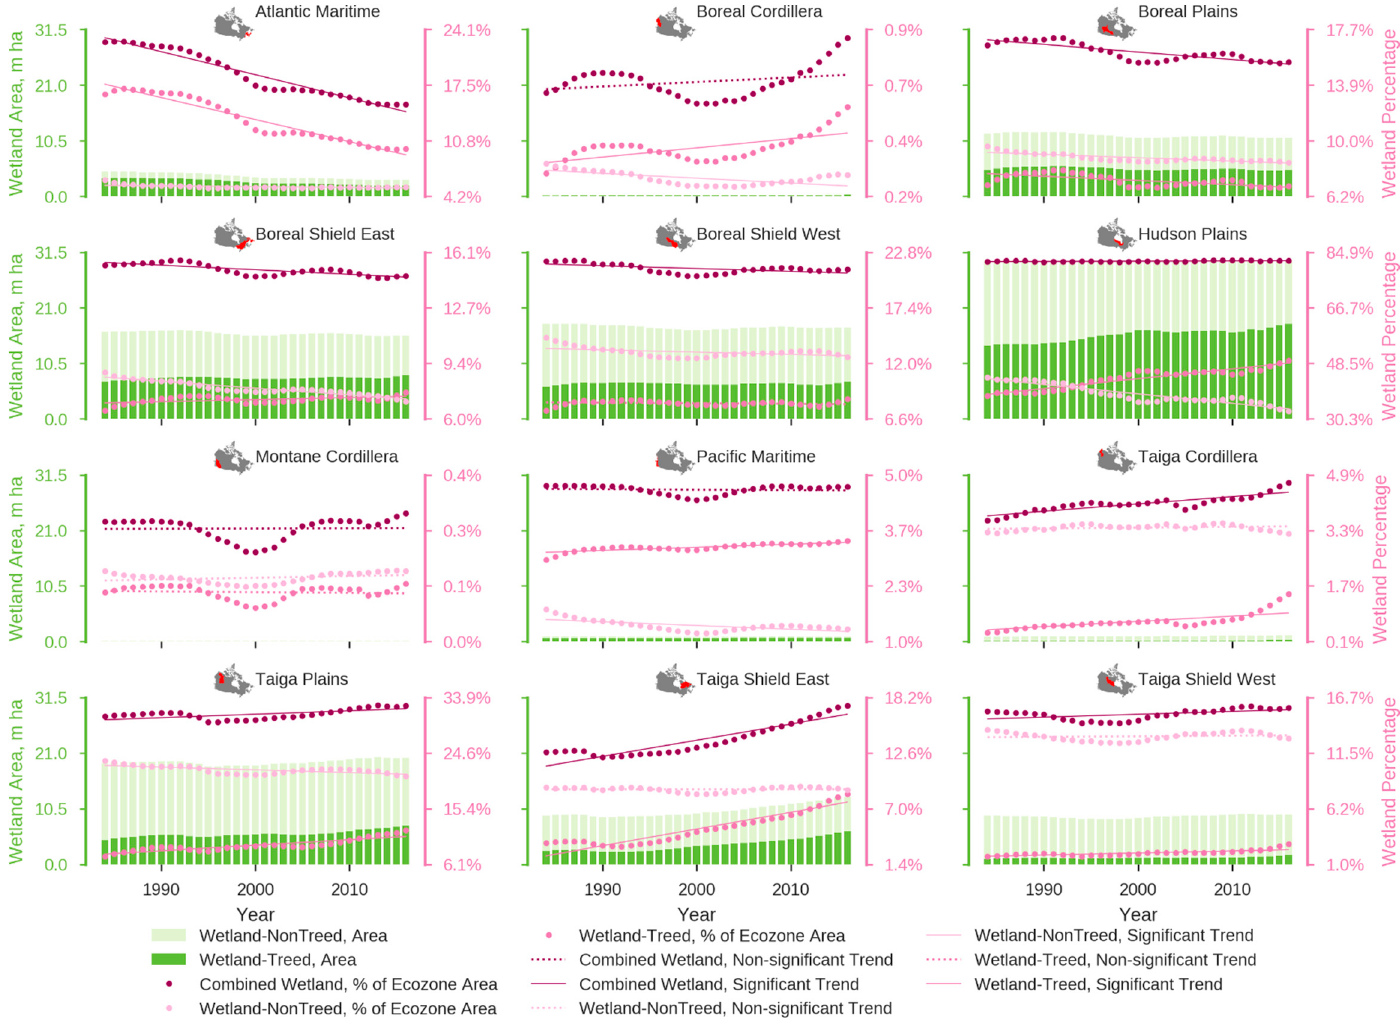
Figure 3. Wetland area (bars, left axis), the percentage (dots, right axis) of each forest-dominated ecozone, and their temporal trends (lines), in Canada.